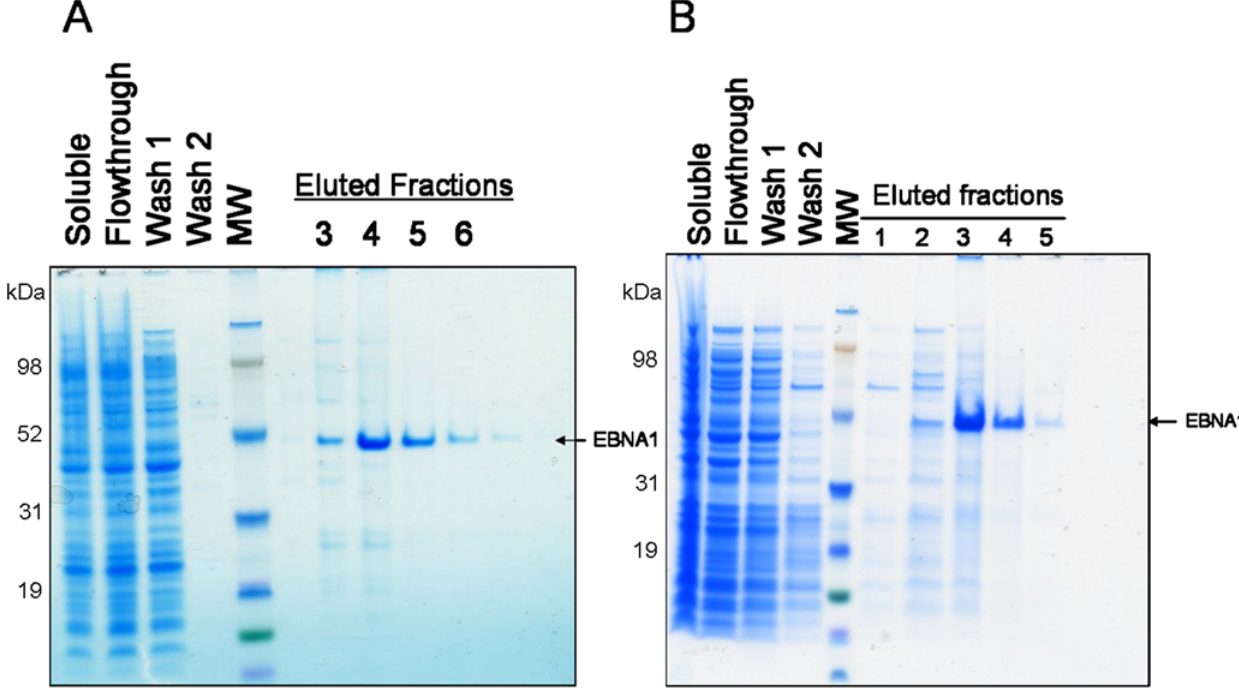
Figure 5. Immunoaffinity chromatography using PR-mAbs. The soluble fraction of whole cell extract from E. coli overexpressing EBNA1 was added to A) mAb 1EB2-Sepharose column and B) mAb 3EB7-Sepharose column, washed, and eluted with TE + 0.75 M AS + 40% PG. Coomassie blue stained gels are shown.